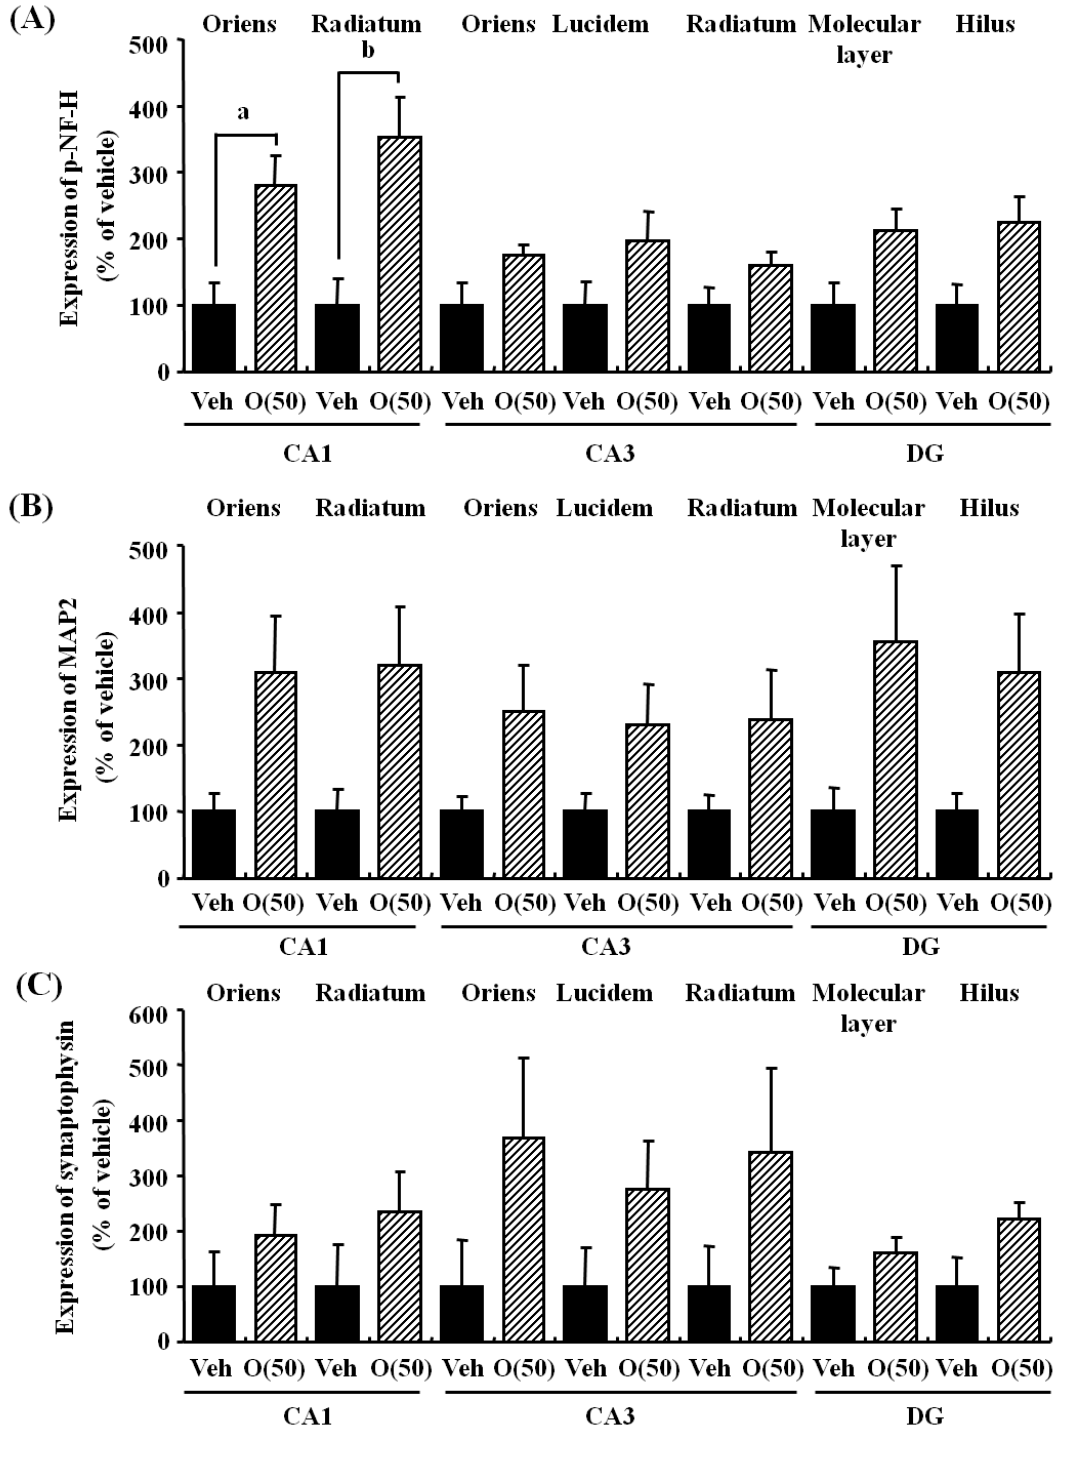
Figure 8. Effects of oligomers on the decrease of axons, dendrites, and synapses in the hippocampus. Fifty-nine-week-old SAMP8 were administered vehicle (Veh, water p.o., n = 3) or oligomers (O (50), 50 mg/kg body weight/day, p.o., n = 3). After seven days of administration, brain slices were immunostained with p-NF-H ( A ), MAP2 ( B ), and synaptophysin antibodies ( C ). The intensities of immuno-positive areas in the hippocampus were quantified. a p = 0.0243; b p = 0.0344 (Student’s t